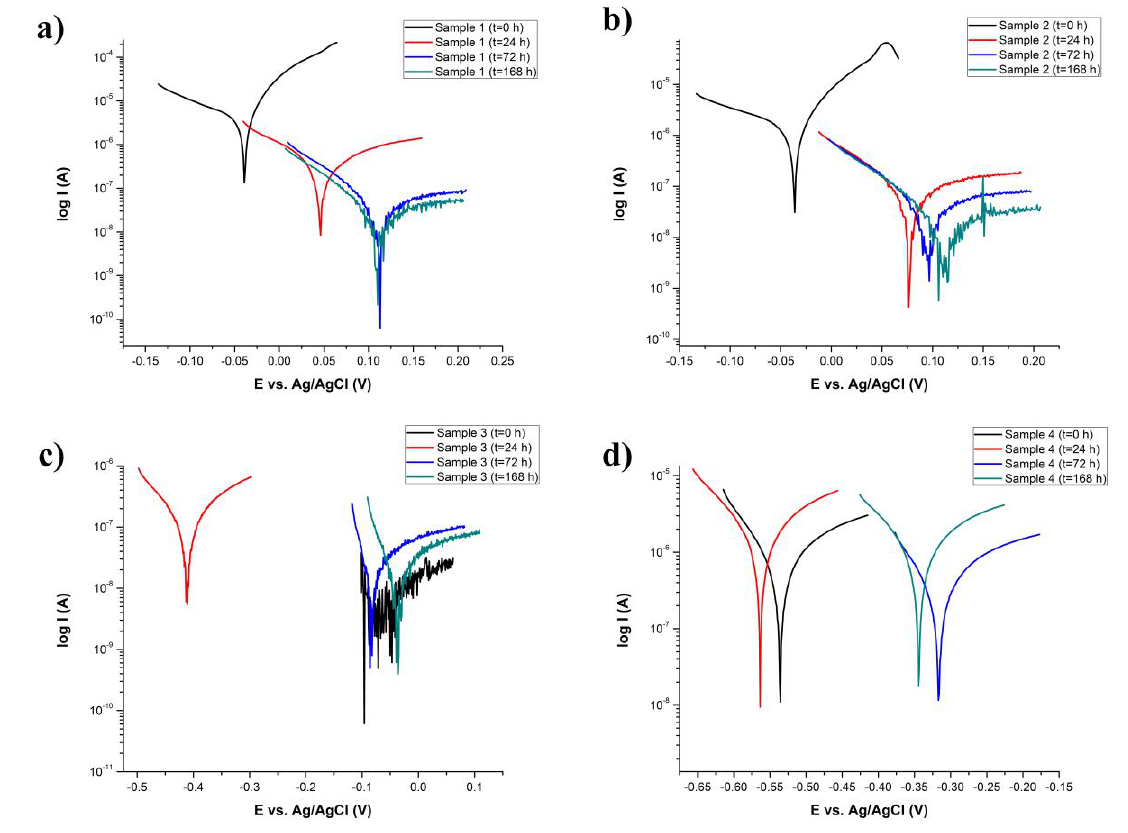
Figure 7. Tafel diagrams for Samples 1 ( a ), 2 ( b ), 3 ( c ), and 4 ( d ) at different electrolyte solution immersion times.